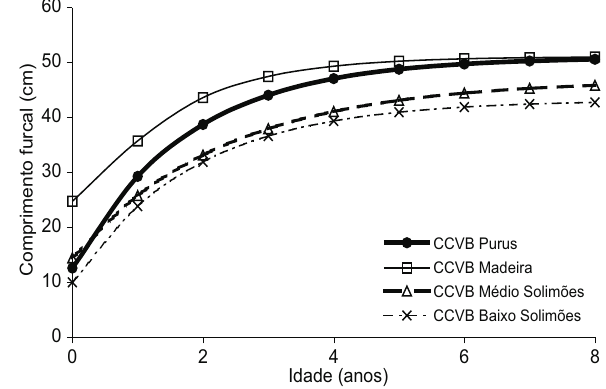
Figura 7. Curvas de crescimento de von Bertallanfy nos quatro sub sistemas